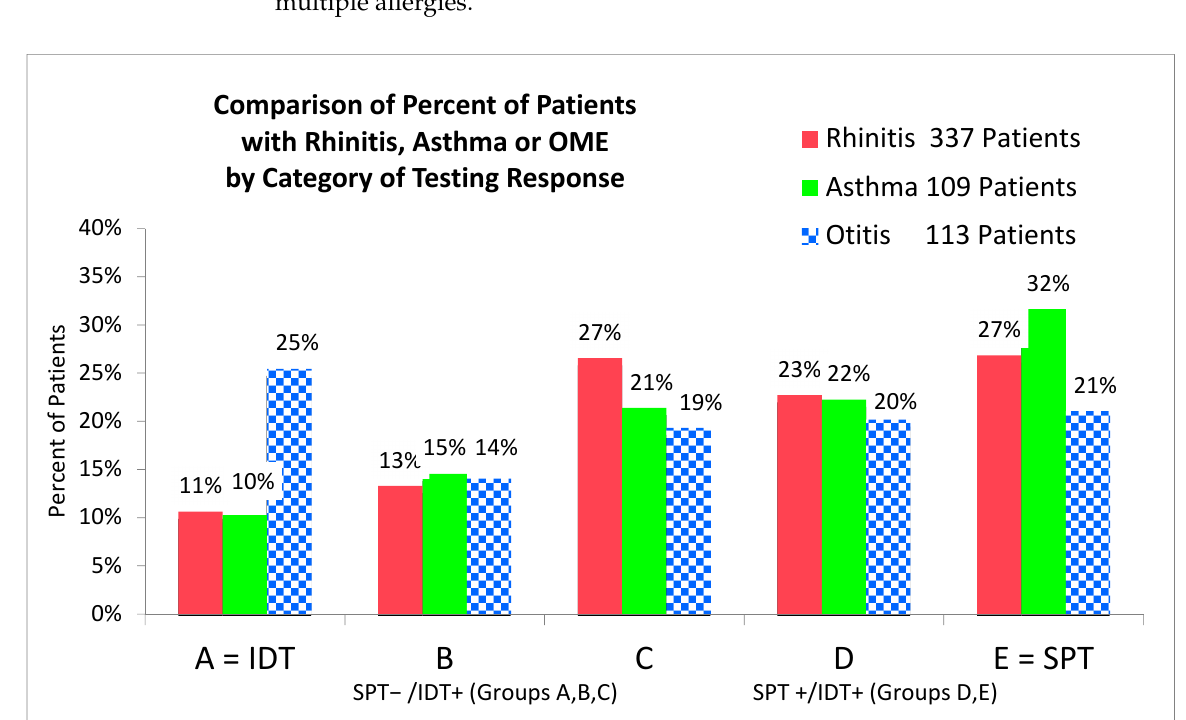
Figure 1. Comparison of Relative Frequency of Patients with Allergic Rhinitis, Asthma or OME by IDT Sensitivity.